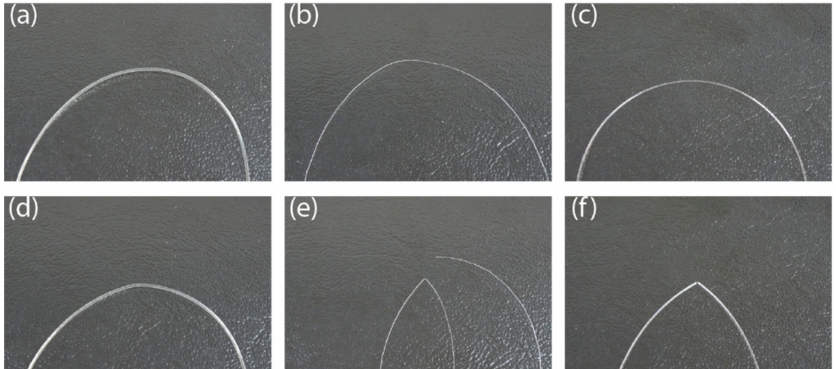
Figure 5. Evaluation of the plastic behavior of optical fibers under bending, with a radius of 1 mm: Empa Geniomer ® ( a ) before testing and ( d ) 2 min after testing; Empa bi-component ( b ) before testing and ( e ) 2 min after testing; GigaPOF 50-SR ( c ) before testing and ( f ) 2 min after